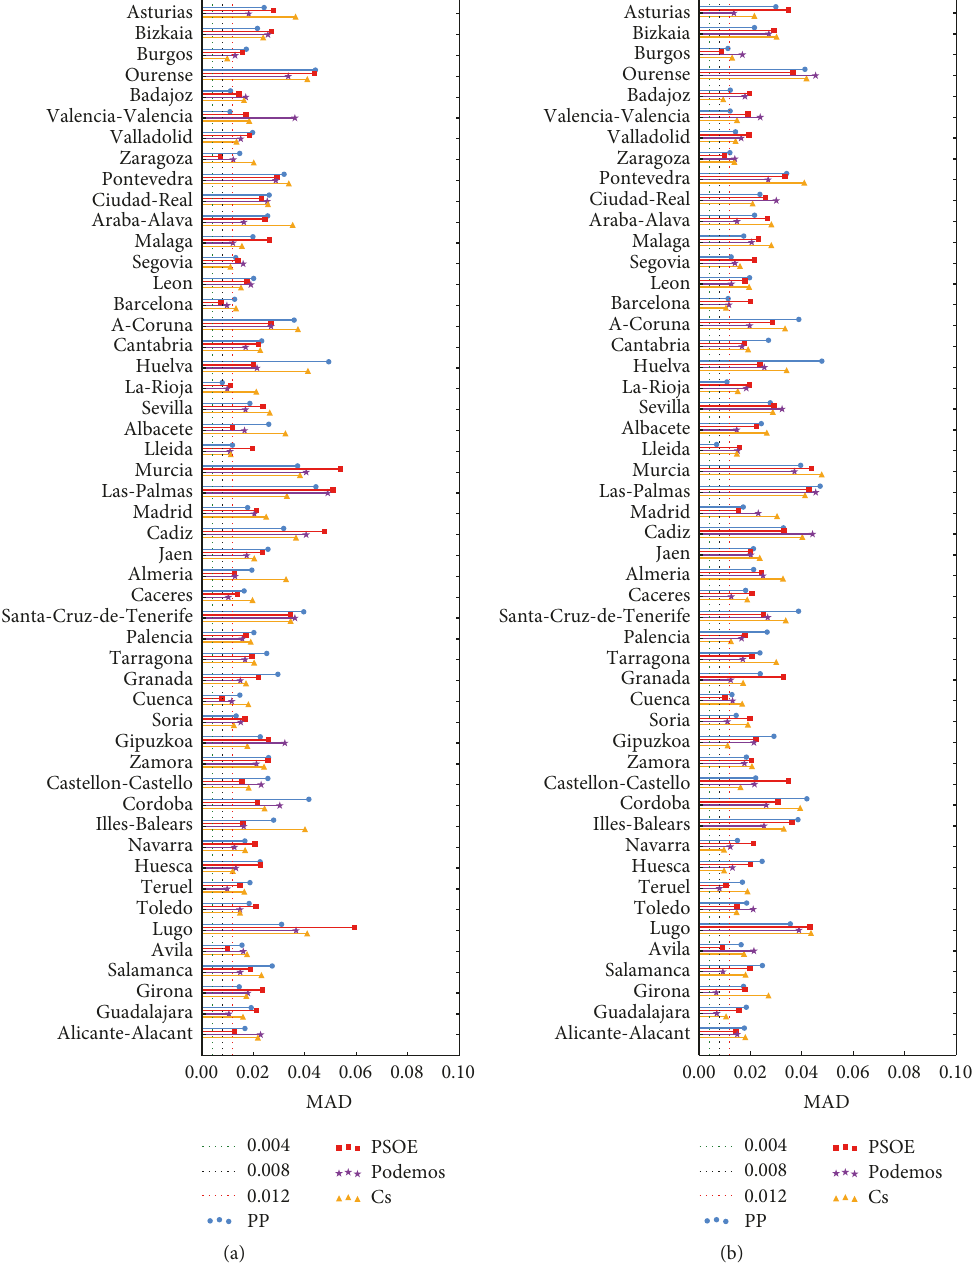
Figure 19: MAD values of the goodness of fit to 1BL for 2015 (a) and 2016 (b) at the aggregation level of precincts. In every case, the critical values for rejection at the 95 and 99% confidence level are shown. For a large majority, we reject conformance to Benford’s law at the precinct level according to MAD, this result being inconsistent with the one found for Pearson’s 𝜒 2 statistic.